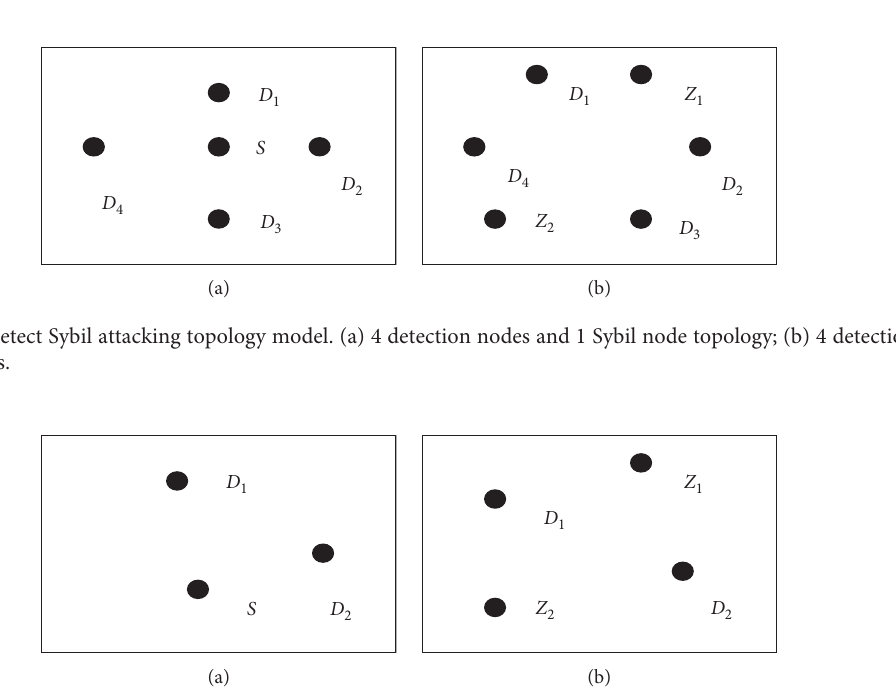
Figure 8: Two nodes detect Sybil attacking topology model. (a) 2 detection nodes and 1 Sybil node topology; (b) 2 detection nodes and 1 normal node